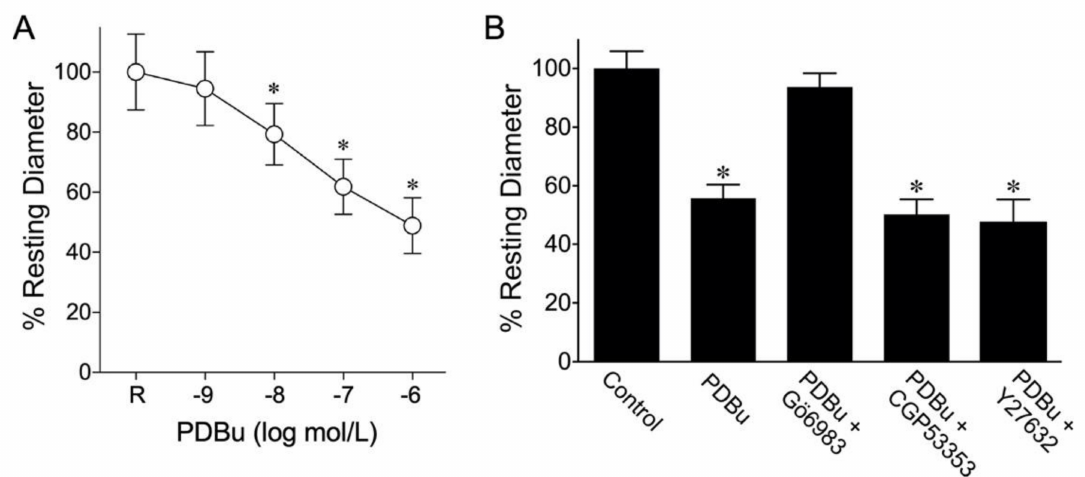
Figure 1. PDBu elicited concentration-dependent constriction of porcine coronary arterioles. ( A ) The low concentration of PDBu (1 nmol/L) had no effect on vascular tone, but higher concentrations ( ≥ 10 nmol/L) caused significant vaso- constrictions ( n = 6). * p < 0.05 vs. resting diameter (R), one-way repeated measures ANOVA with Dunnett’s multiple comparison test. ( B ) PDBu-induced vasoconstriction (PDBu 0.1 µ mol/L, n = 5) was prevented by the pan-PKC inhibitor Gö6983 (1 µ mol/L, n = 5) but was not affected by the PKC β 2 inhibitor CGP53353 (0.3 µ mol/L, n = 5) or Rho kinase inhibitor